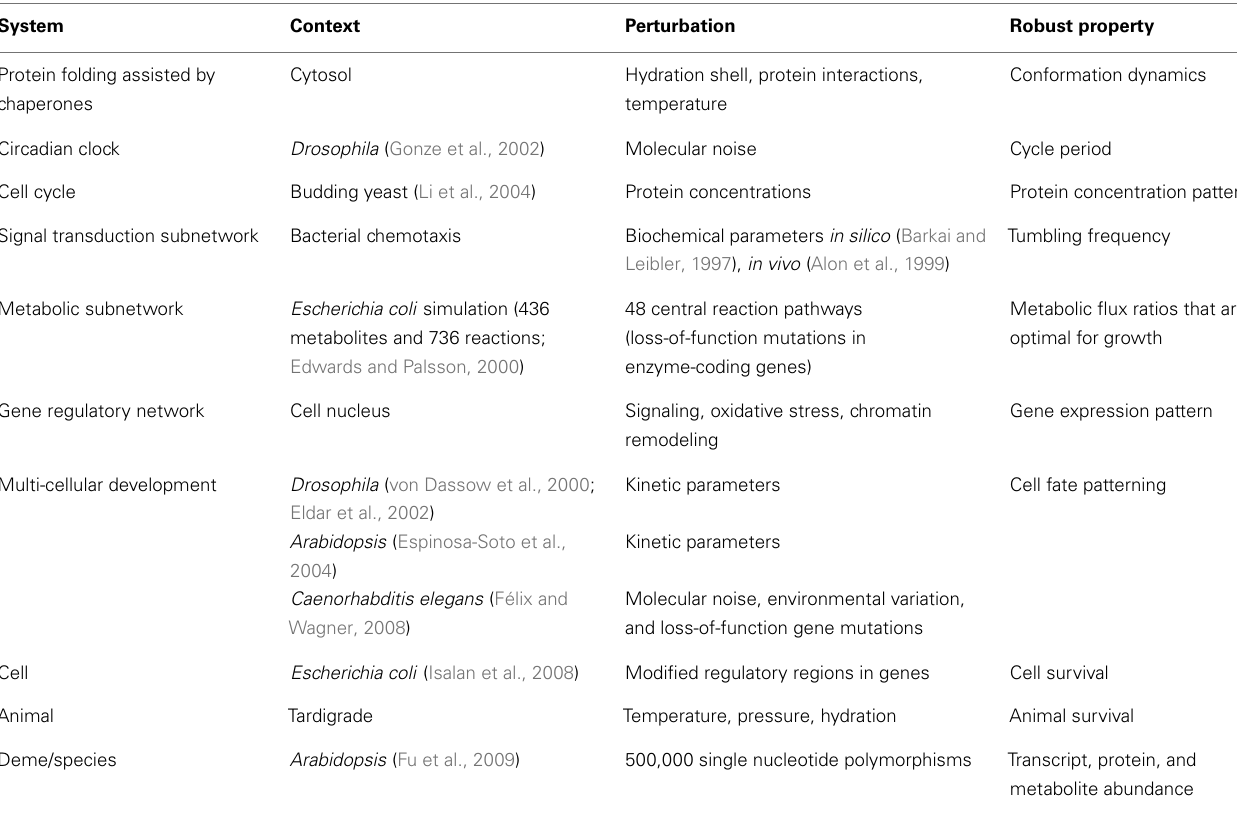
Table 1 | Robustness in different biological